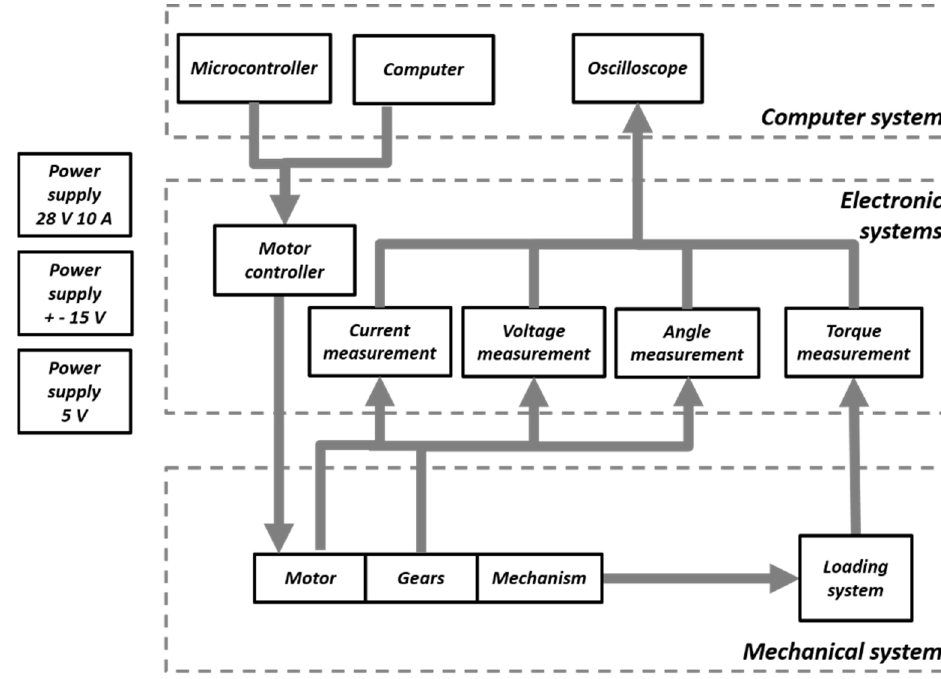
Figure 22. Block diagram of the test stand.